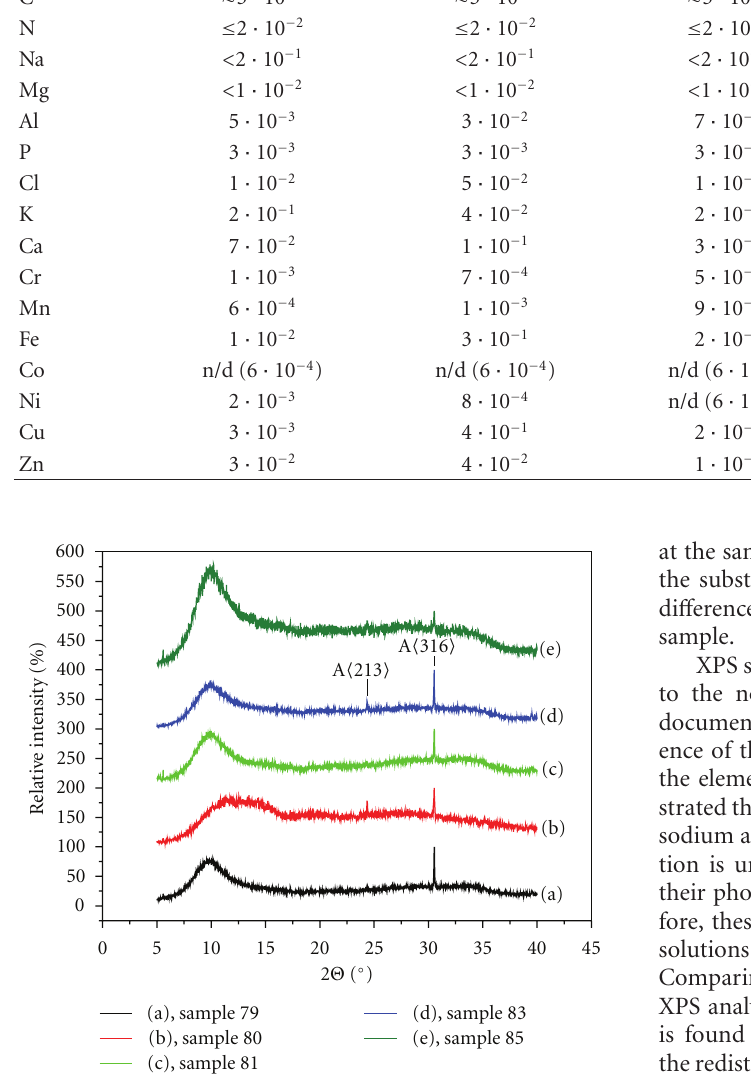
Figure 2: X-ray di ff raction patterns for anatase TiO 2 :(Fe, S) thin films obtained from the external evaporator in a controlled Ar/O 2